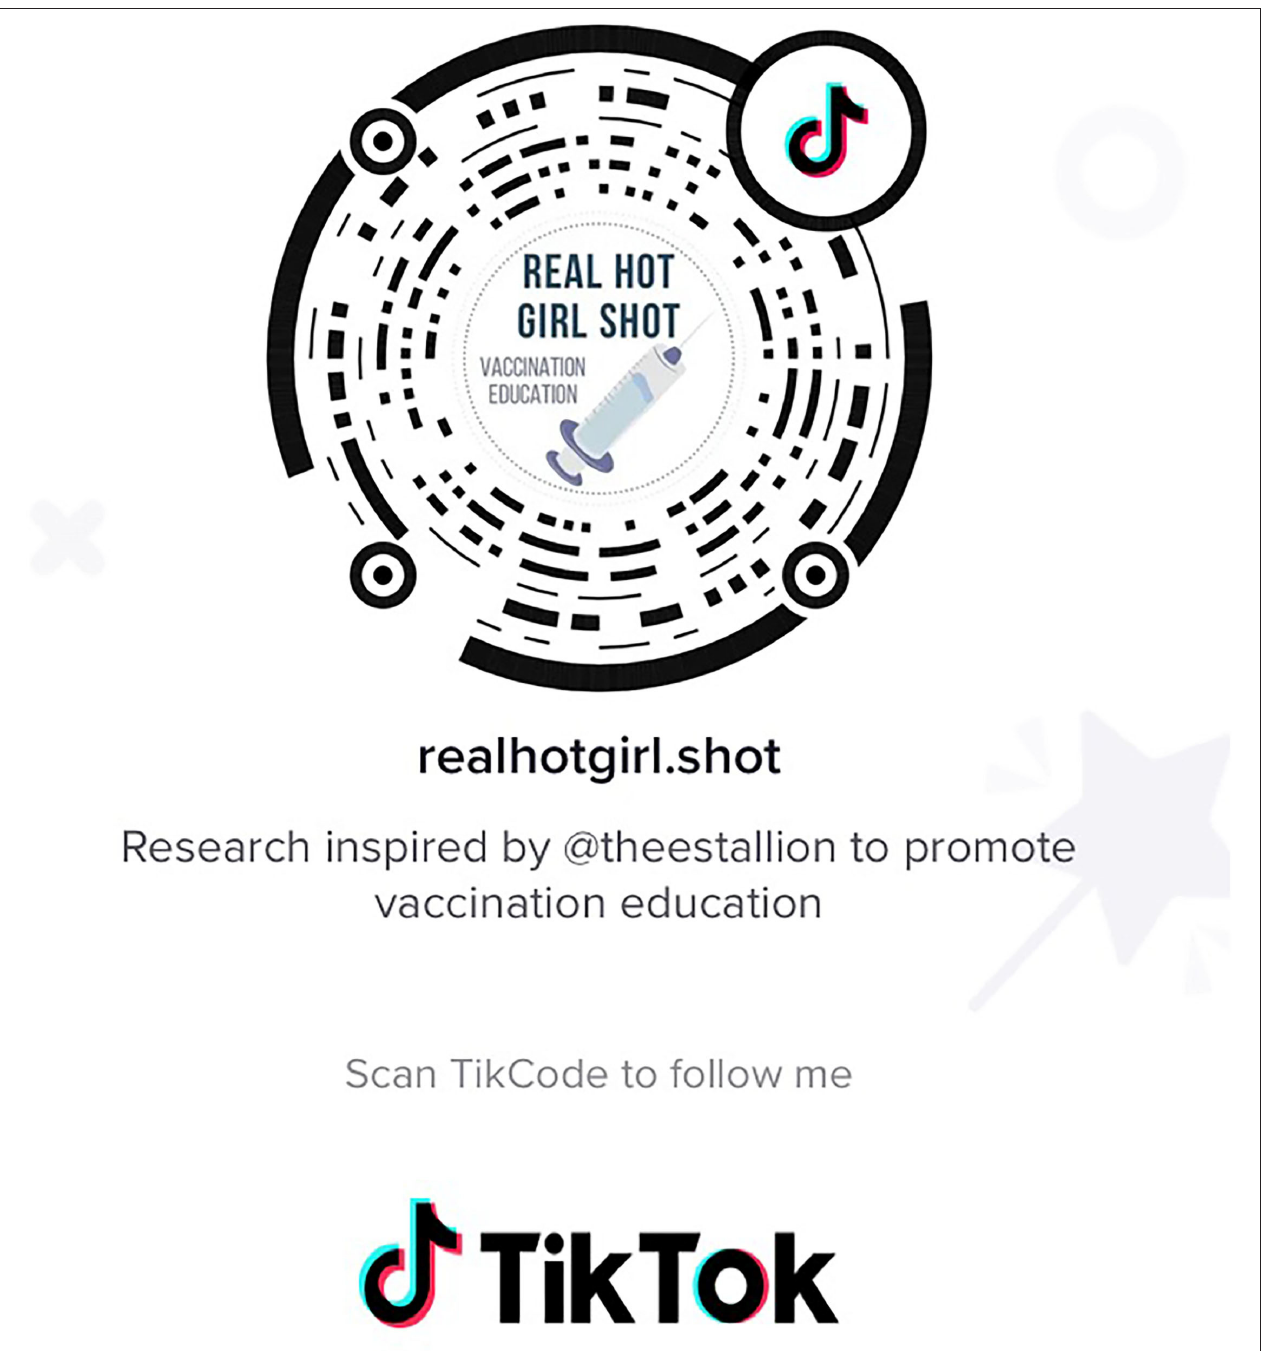
FIGURE 1 | Branded logo for social